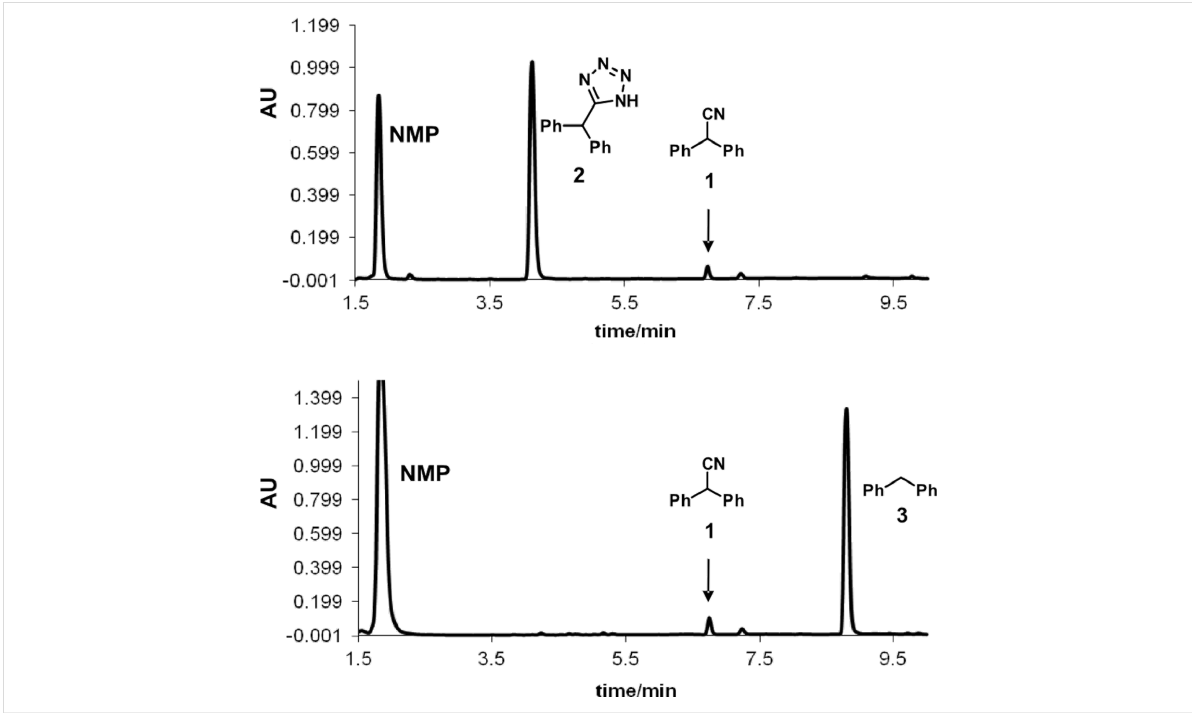
Figure 1: HPLC-UV chromatograms (215 nm) of crude reaction mixtures from the cycloaddition of diphenylacetonitrile ( 1 ) with NaN 3 (Scheme 1) comparing microwave batch (top) and continuous flow conditions (bottom). Reaction parameters: 220 °C, ≈ 16 min, 2.5 equiv NaN 3 , NMP/AcOH/H 2 O